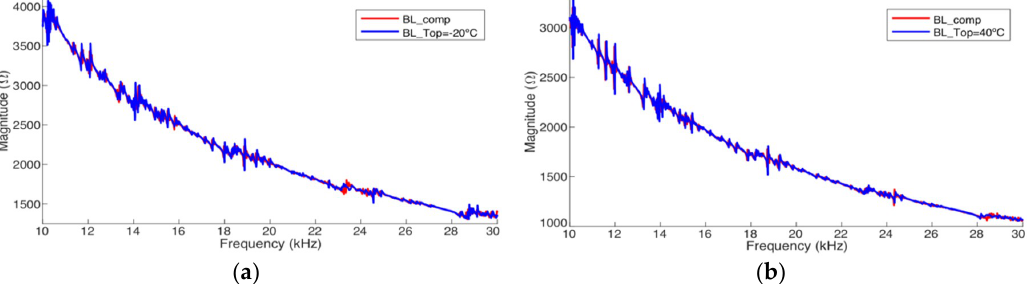
Figure 18. Complete compensation for pipe-1/PZT-1 (Experiment): ( a ) from −40 °C to −20 °C and ( b ) from +80 °C to +40 °C.